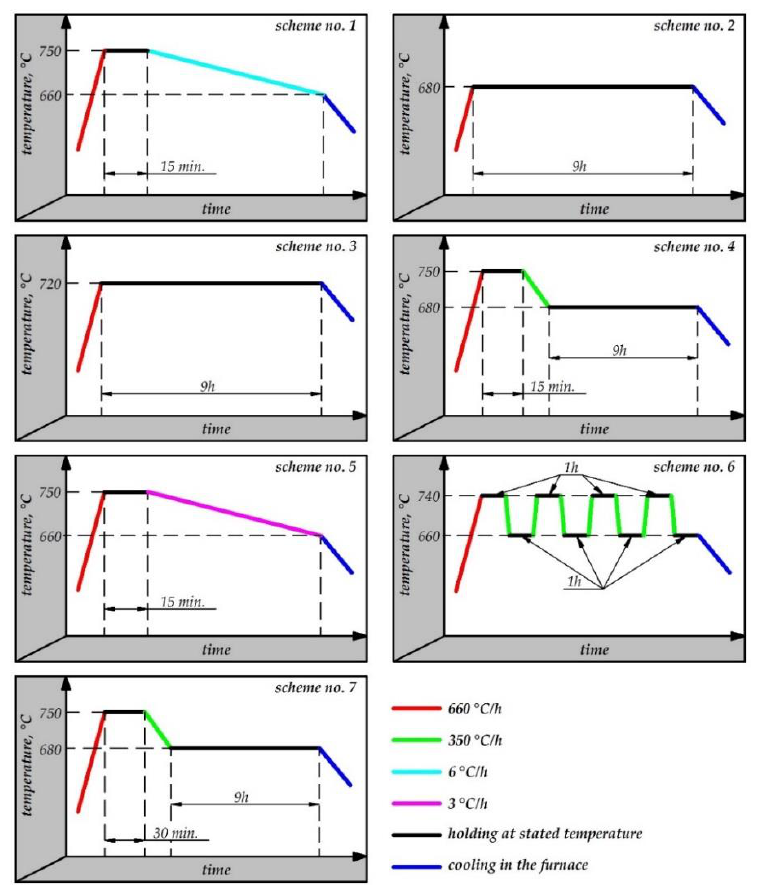
Figure 1. Time vs. temperature schemes of the annealing process.